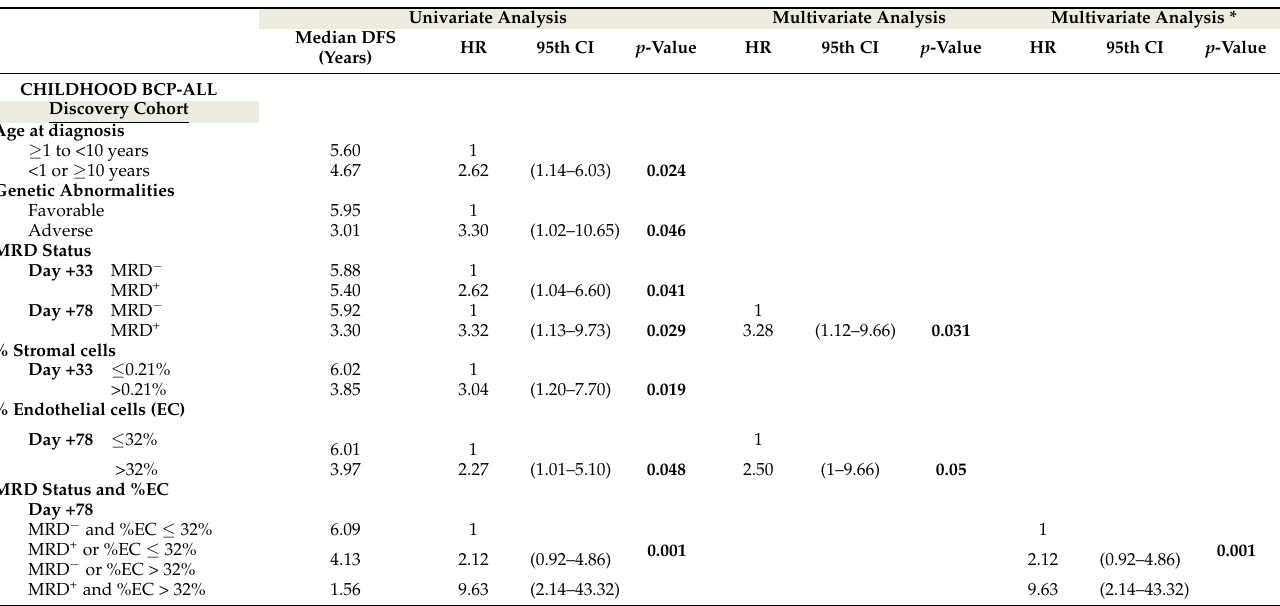
Table 2. Univariate and multivariate analysis of prognostic factors for disease-free survival (DFS) of children diagnosed with BCP-ALL included in the discovery cohort (n =